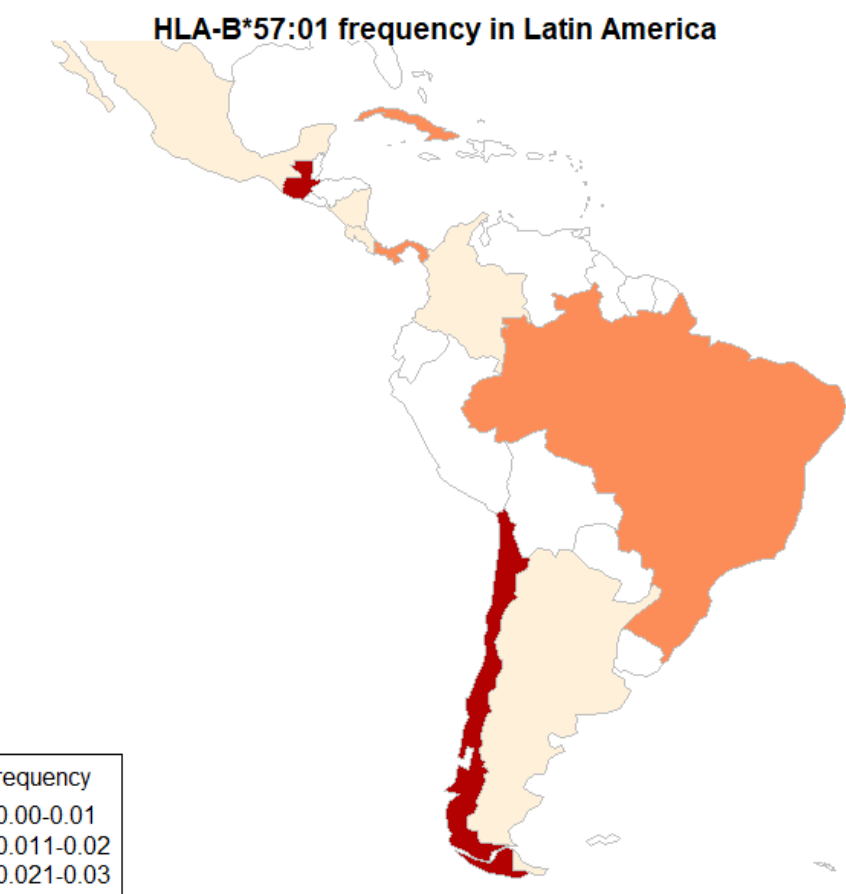
Figure 1. Frequency of HLA-B*57:01 allele in Latin American countries. Frequencies were retrieved from the Allele Frequency Net Database (http:// www.allelefrequencies.net/). Data were available for Argentina, Brazil, Chile, Colombia, Costa Rica, Cuba, Guatemala, Mexico, Nicaragua and Panama. When more than one frequency was provided for a single country, mean values were